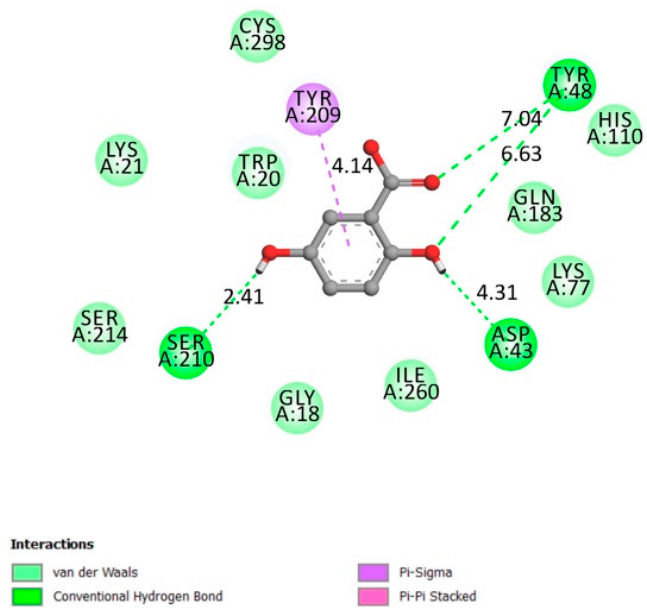
Figure 5. Two-dimensional scheme of the GA interactions with aldose reductase receptor.